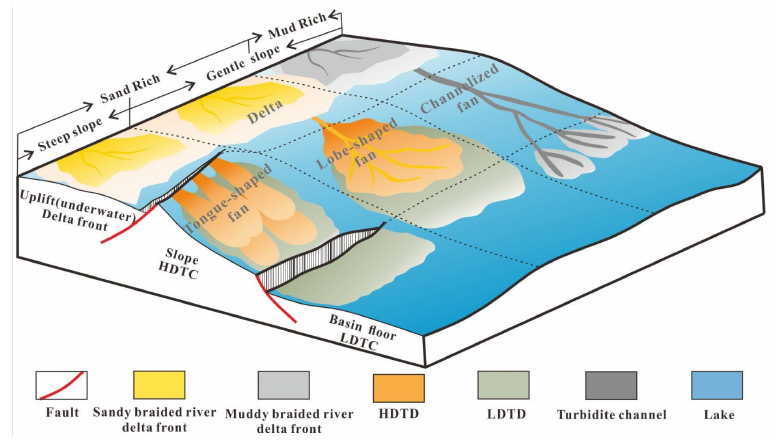
Figure 13. Patterns of sublacustrine fan morphology.